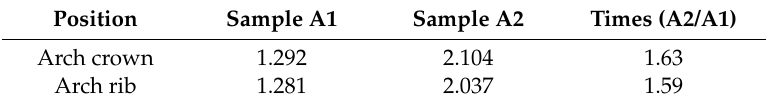
Table 5. The earth pressure coefficients of different samples in numerical simulations.